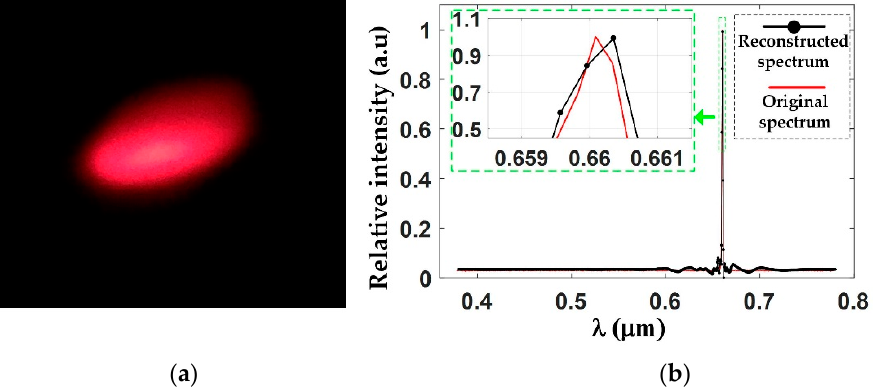
Figure 8. Laser spectrum measurement experiment: ( a ) Laser light spot; ( b ) Results of compressed sensing spectrum measurements.